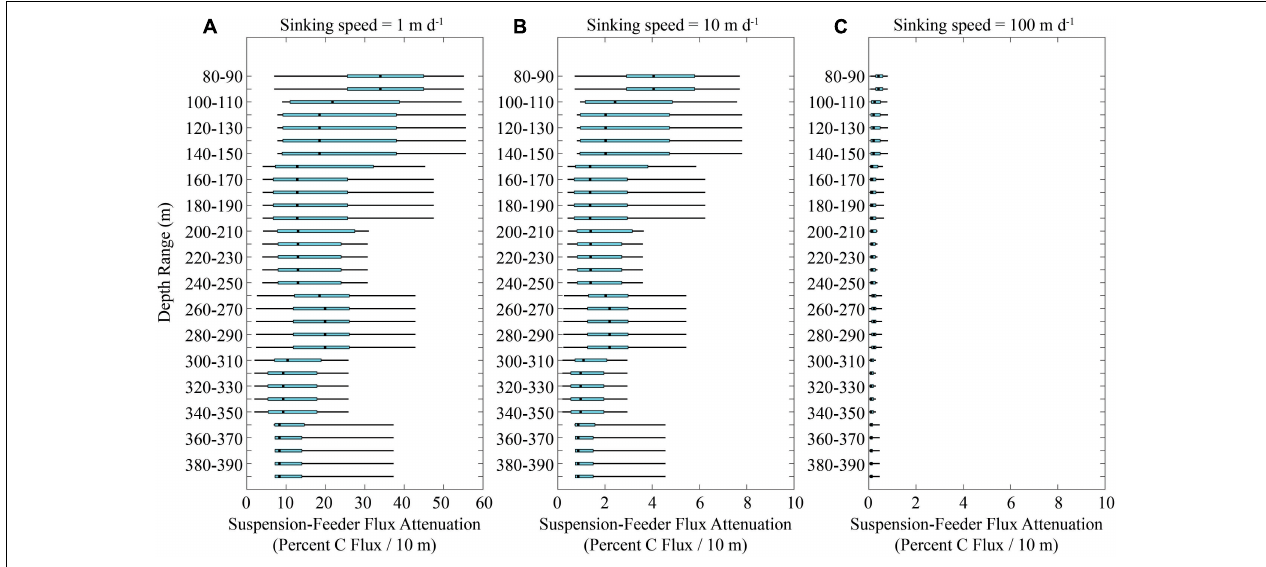
FIGURE 6 | Computed carbon flux attenuation mediated by suspension-feeding copepods, euphausiids, appendicularians, and ostracods if particles are sinking at 1 m day − 1 (A) , 10 m day − 1 (B) , or 100 m day − 1 (C) . Light blue boxes show quartiles (median is black line) and thin black lines show 95% confidence intervals (computed using MATLAB function quantile).